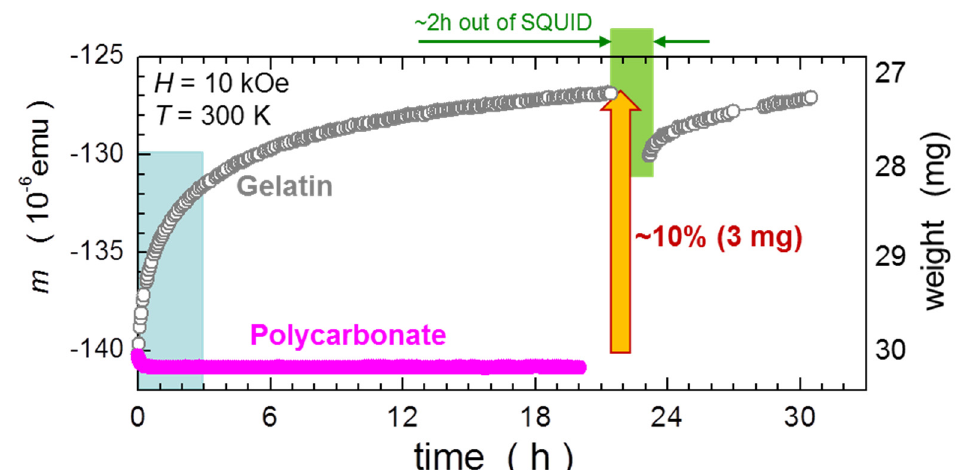
Figure 1. Comparison of time dependencies of the magnetic moment m of typical gelatin (grey symbols) and polycarbonate (magenta) capsules. All magnetic data are normalized to the standard 30 mg capsule and the equivalent scale of mass is given on the right Y-scale of the graph, established from weights of the capsules taken just before inserting to and just after removing from the SQUID sample chamber. The green band in the background indicates the time the gelatin capsule spent in open air during a break in the measurements. The light-blue band at the beginning of the graph marks the typical time needed for the execution of a standard hysteresis curve. The capsules are harness-free mounted in a diameter-reduced straw, as explained in Section 2.2.